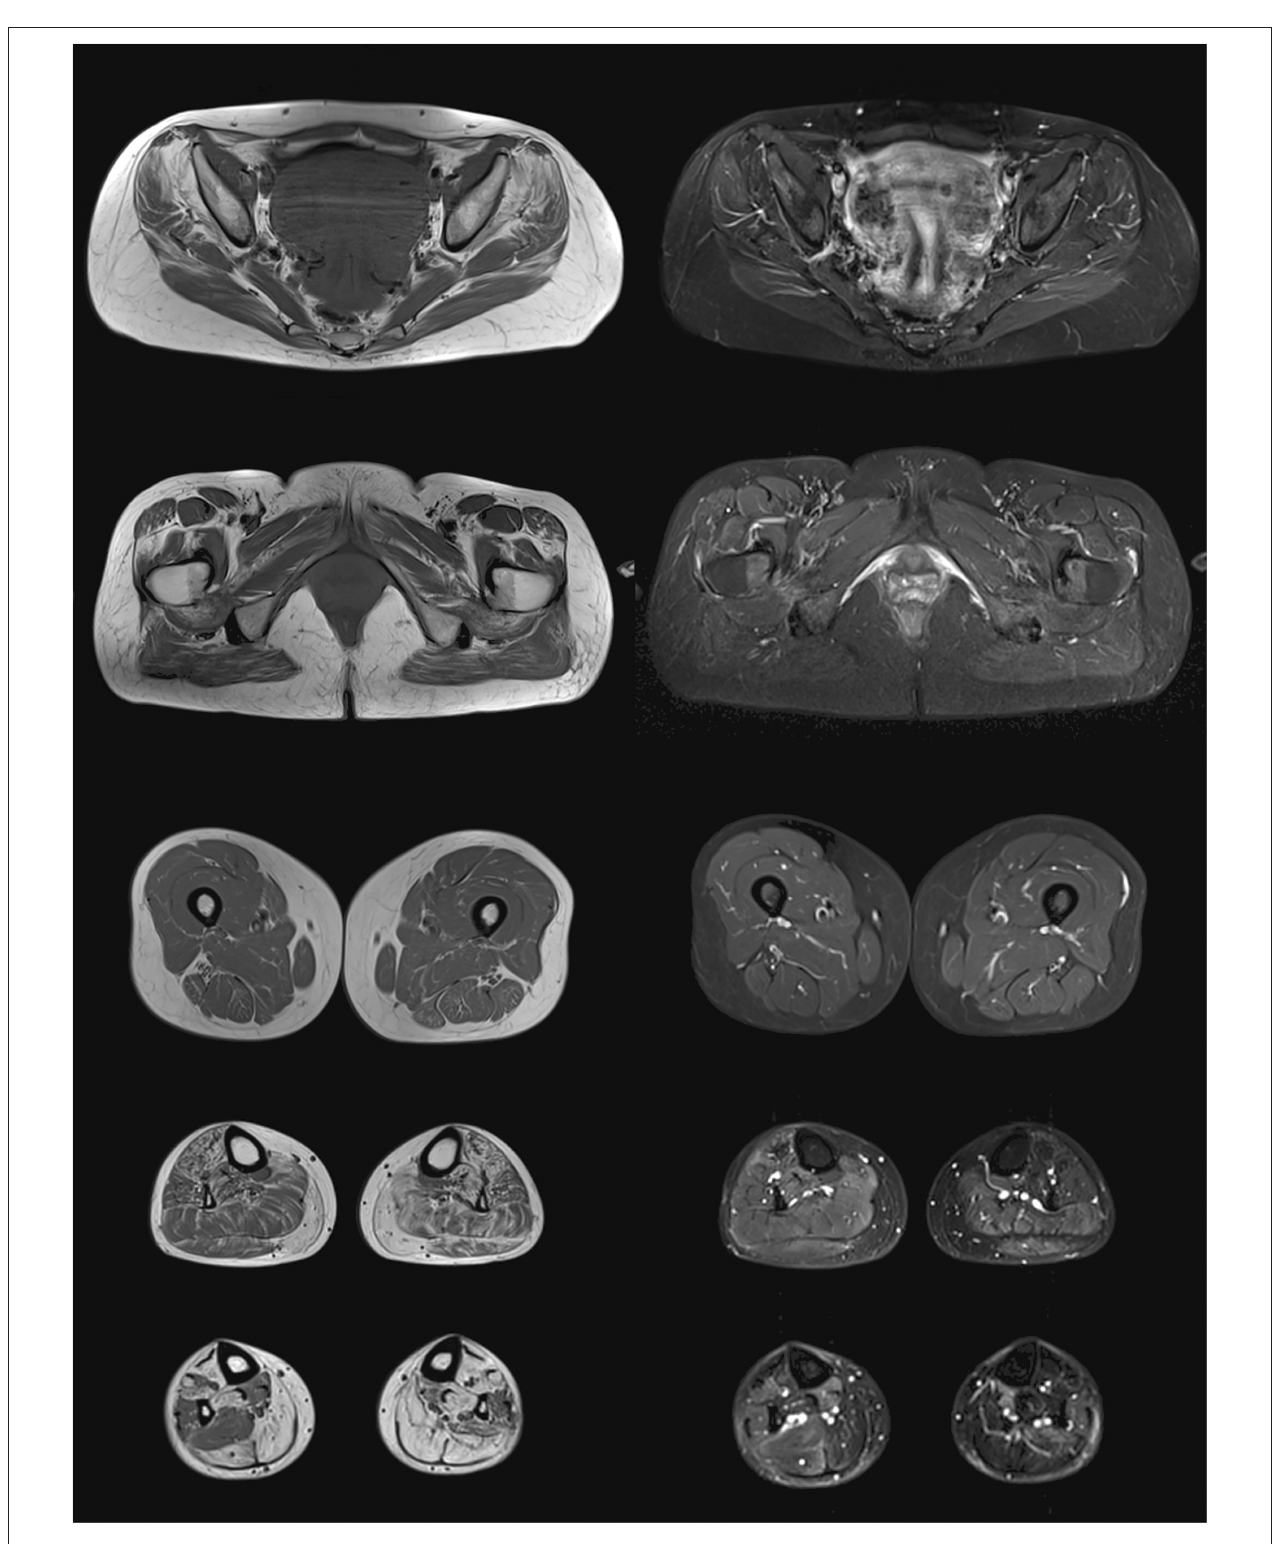
FIGURE 1 | Lower body skeletal muscle MRI from the propositus. On the left panel, T1 images showing fatty degeneration as hyperintense signal in gluteus minimus and medius , adductor maximus , quadratus femoris , tibialis anterior , gastrocnemius , and soleus . On the right panel, STIR images showing interstitial edema as hyperintense signal in partially infiltrated muscles of the